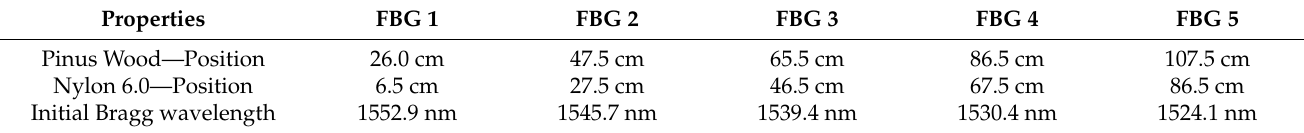
Table 2. FBGs initial wavelength and positions on the wooden and nylon